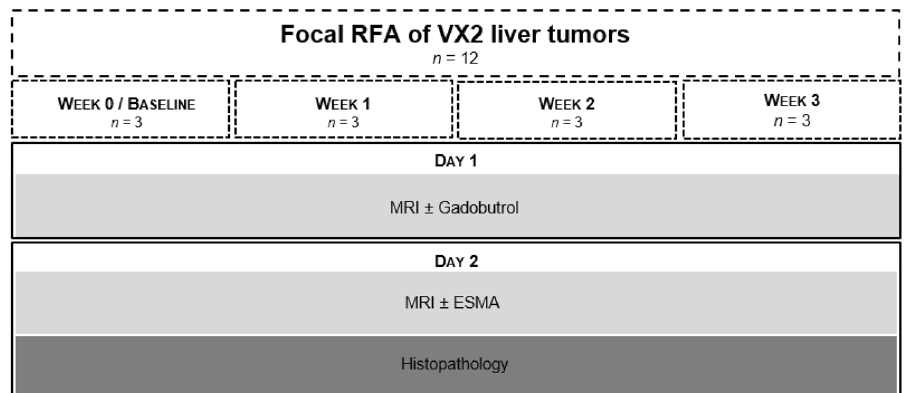
0 (n = 3; 1–2 days), (II) 1 week (n = 3; 7–8 days), (III) 2 weeks (n = 3; 14–15 days) and (IV) 3 weeks (n = 3; 21–22 days) after RF ablation. At each time point imaging studies were conducted on two consecutive days.